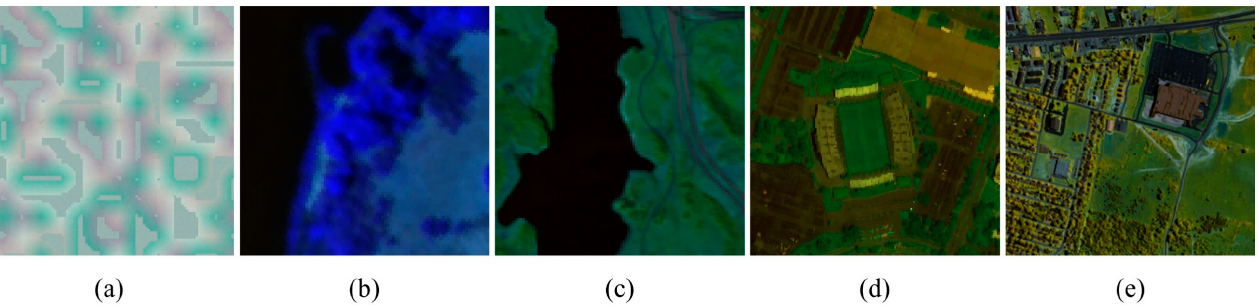
Figure 6. RGB images of the synthetic and real HSIs adopted in the experiments. ( a ) Synthetic data. ( b ) Samson. ( c ) Jasper Ridge. ( d ) Houston. ( e ) Urban. ( b ) Samson. ( c ) Jasper Ridge. ( d ) Houston. ( e )